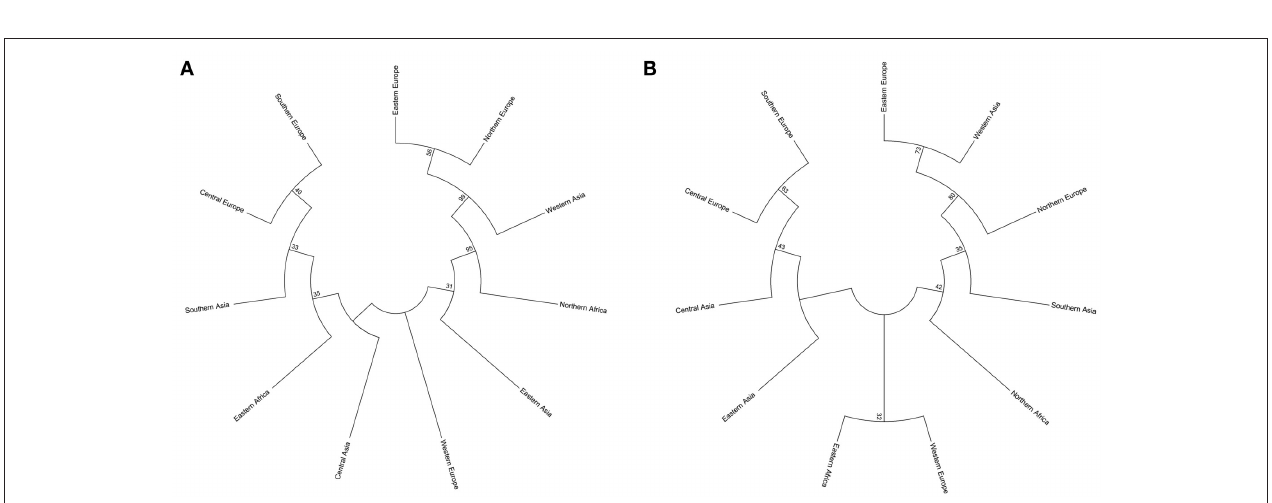
FIGURE 6 | Two UPGMA dendrograms showing the relationship of the geographic groups of the 43 grasspea accessions using Nei and Roychoudhury’s (1974) genetic distance. (A) Based on 87 SSR markers and (B) based on 42 SNP markers.